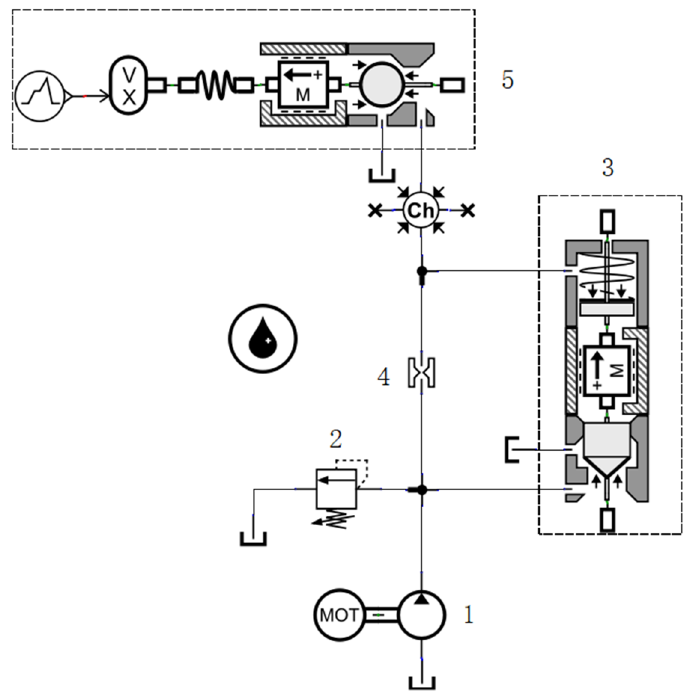
Figure 2. AMESim simulation model of a hydraulic system based on a digital relief valve as a pres- sure regulator. 1—Pump being tested; 2—safety valve; 3—main valve section; 4—pilot spool damp-